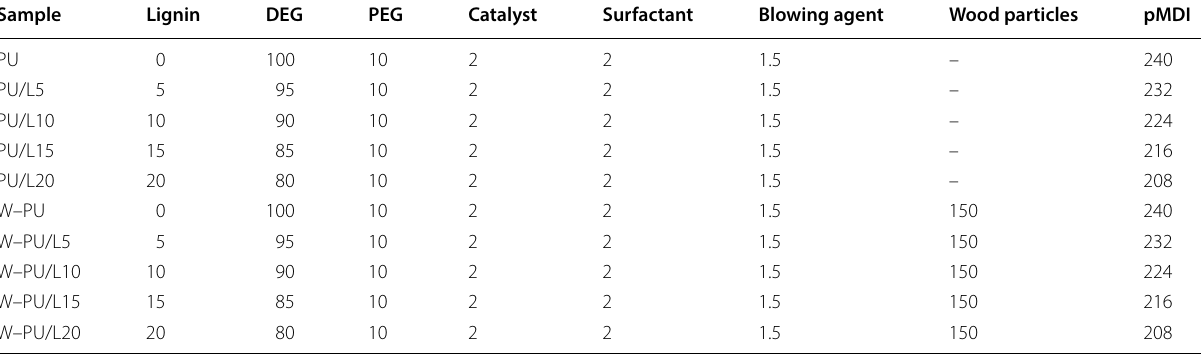
Table 1 Nomenclature and compositions of rigid PU and W–PU foams containing varying lignin contents (parts by